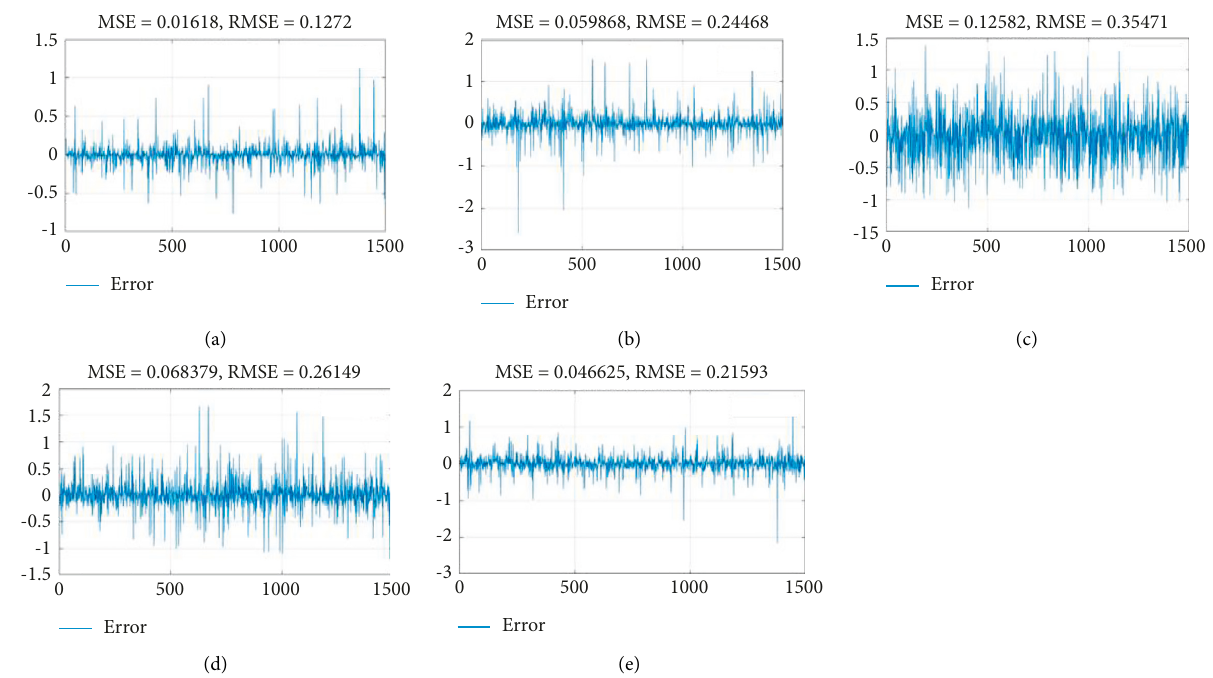
Figure 8: Best error results. (a) SCM-ANFIS for joint 1; (b) GP-ANFIS for joint 2; (c) GP- ANFIS for joint 3; (d) GP-ANFIS for joint 4; (e) GP-ANFIS for joint 5.